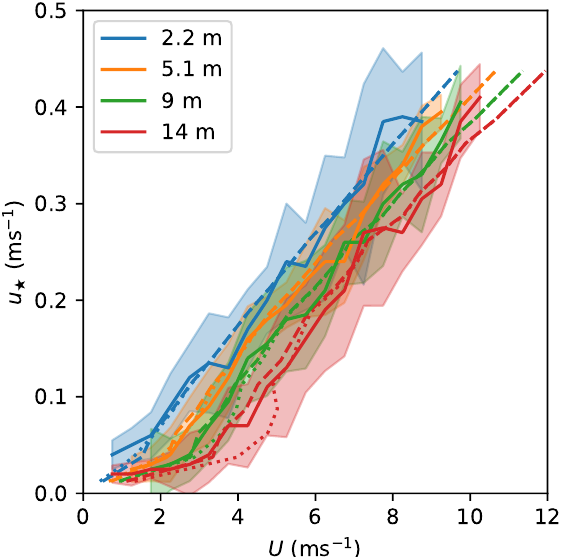
Figure 4. The u (cid:63) − U relationship obtained using MOST for the observational levels of the SHEBA tower. Solid curves represent observations, dotted, MOST with Businger–Dyer stability functions, and dashed, MOST with SHEBA stability